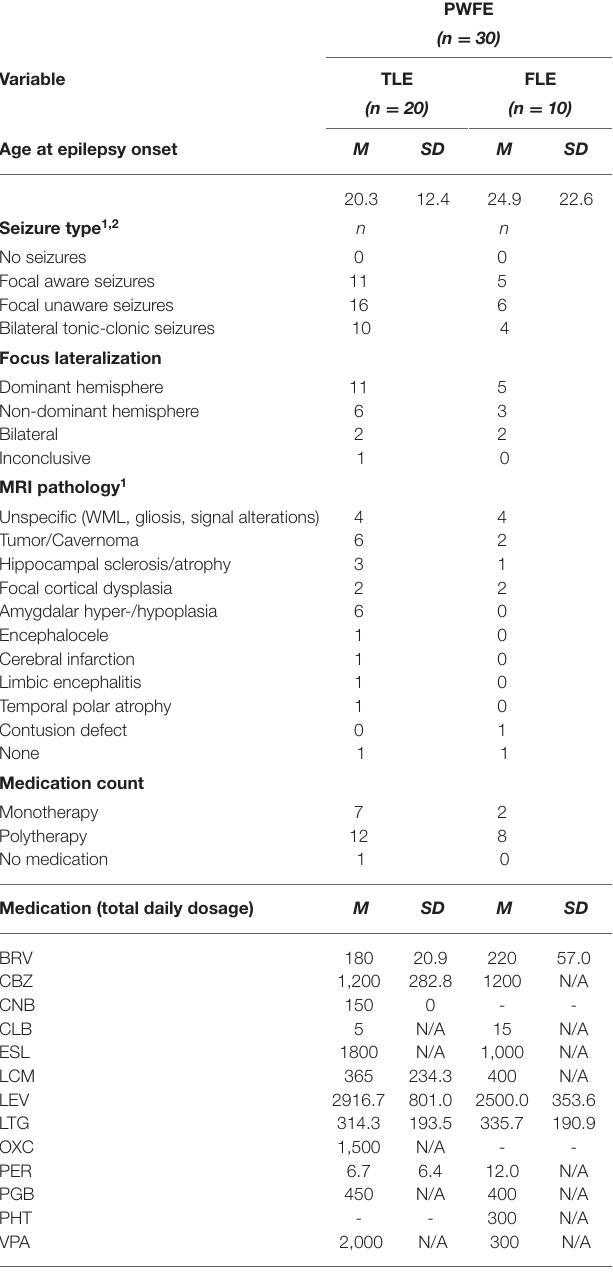
TABLE 1 | Clinical features of the entire patient cohort and subgroups. TABLE 2 | Demographic parameters and cognitive measures for epilepsy patients